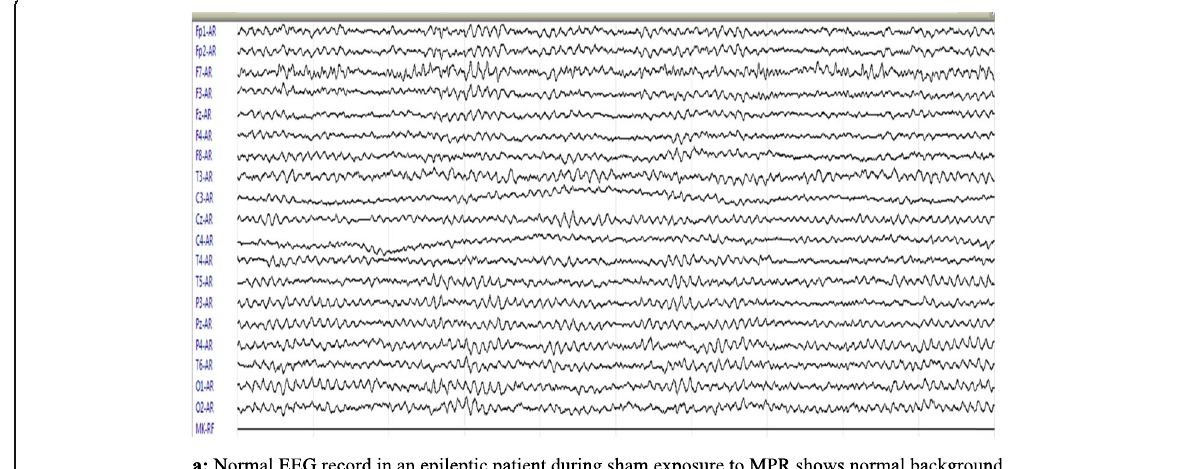
Table 2 Number of epileptic events during sham, real, and after-exposure to MPR The number of events in EEG Sham exposure (15 min)